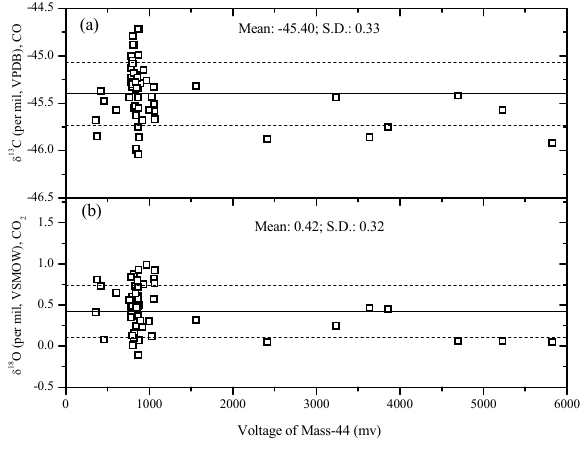
Fig. 2. Measurements of (a) δ 13 C and (b) δ 18 O for calibration gas versus voltage mass-44 ranging from 400mv to 6V. Mean value of δ 13 C(CO): − 45.40‰ (with standard deviation 0.33‰); mean value of δ 18 O(CO 2 ) : 0.42‰ (with standard deviation 0.32‰). Sample size is linear with voltage of mass-44 and 700pmolCO gives 1V for the signal of voltage mass-44.